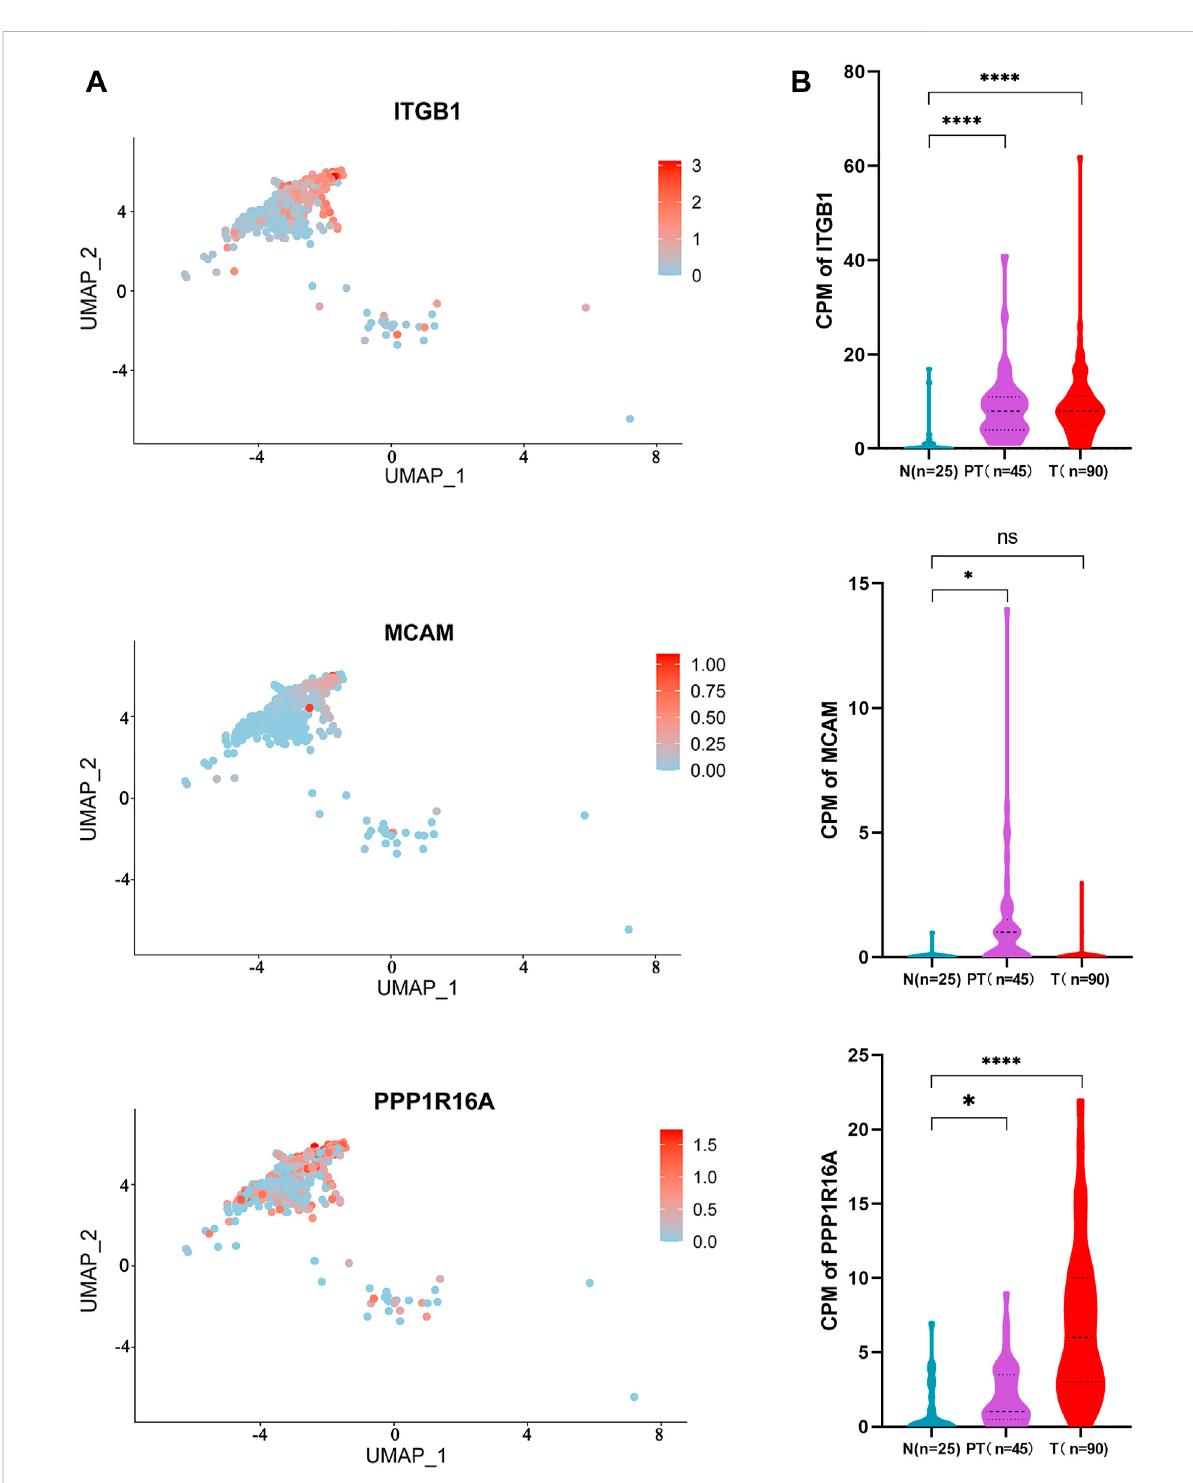
FIGURE 5 Distribution and expression of the 3-gene signature in HCC tissues. (A) UMAP plot showing the distribution of the three genes in HCC tissues; and (B) expression of the three genes in different spatial parts of the HCC tissues are shown in the violin plot. Independent student ’ s t -test, ****, p <